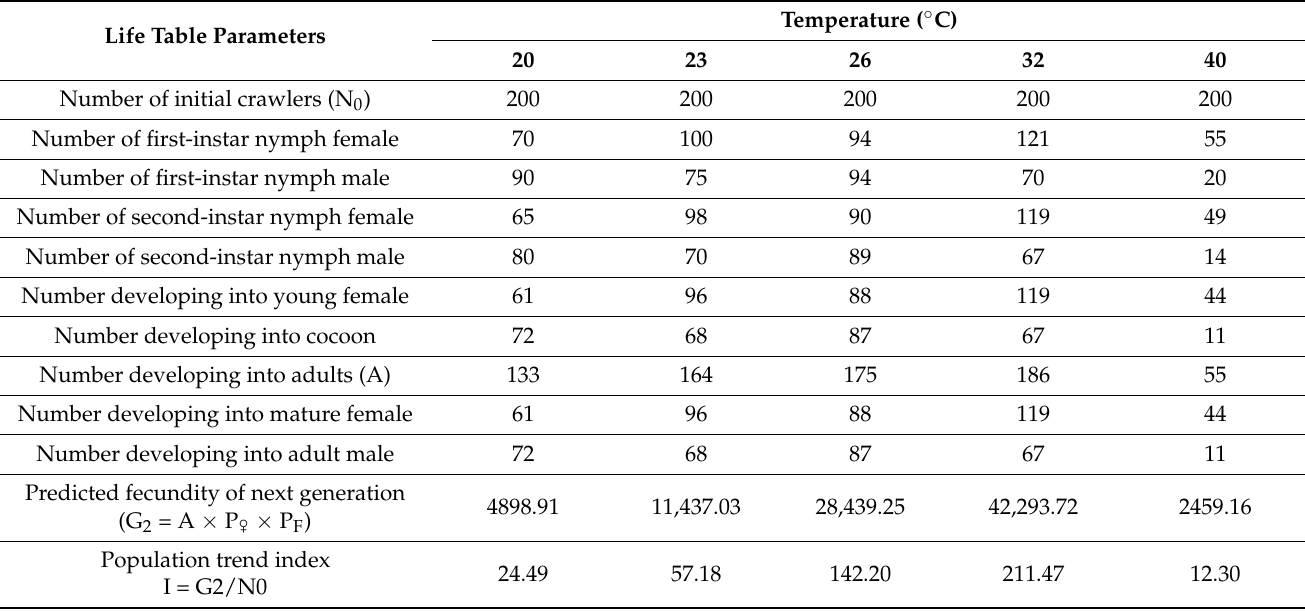
Table 5. Life table parameters of D. opuntiae at different constant temperatures (20, 23, 26, 32, and 40 ◦